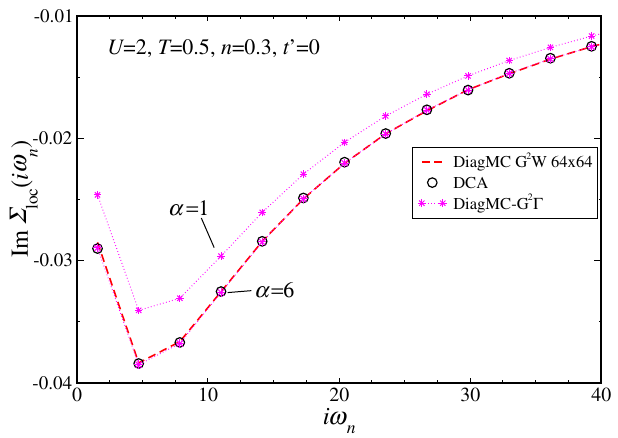
FIG. 15. Imaginary part of the local self-energy, Im Σ U=t ¼ 2 , T=t ¼ 0 . 5 and n ¼ 0 . 3 from DCA and DiagMC. In the case of DiagMC- G 2 Γ , we label α , the series order from Eq. (7).